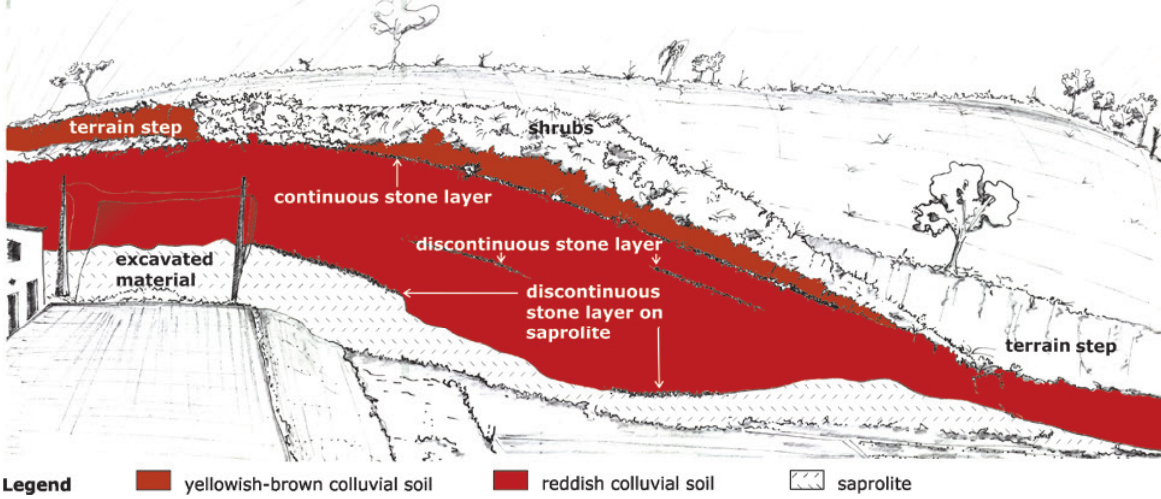
Figure 6 - Multilayered colluvium over saprolite with various stone layers. Profi le in the valley of Rio Formiga, municipality of